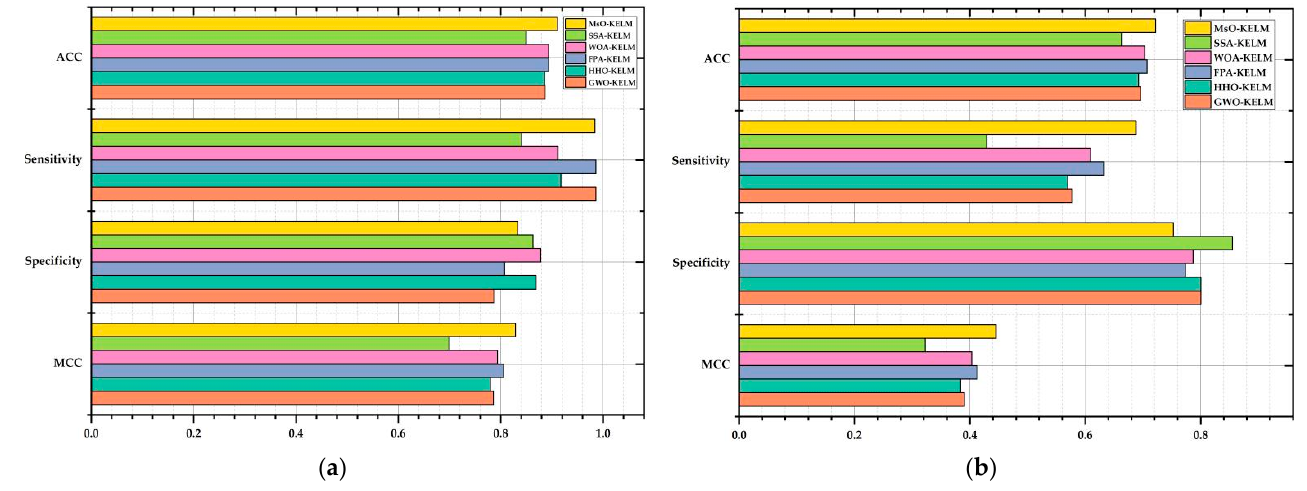
Figure 6. The figure of evaluation metric results on Autistic and Heart Disease. ( a ) the evaluation criterion result on Autistic; ( b ) the evaluation criterion result on Heart Disease.